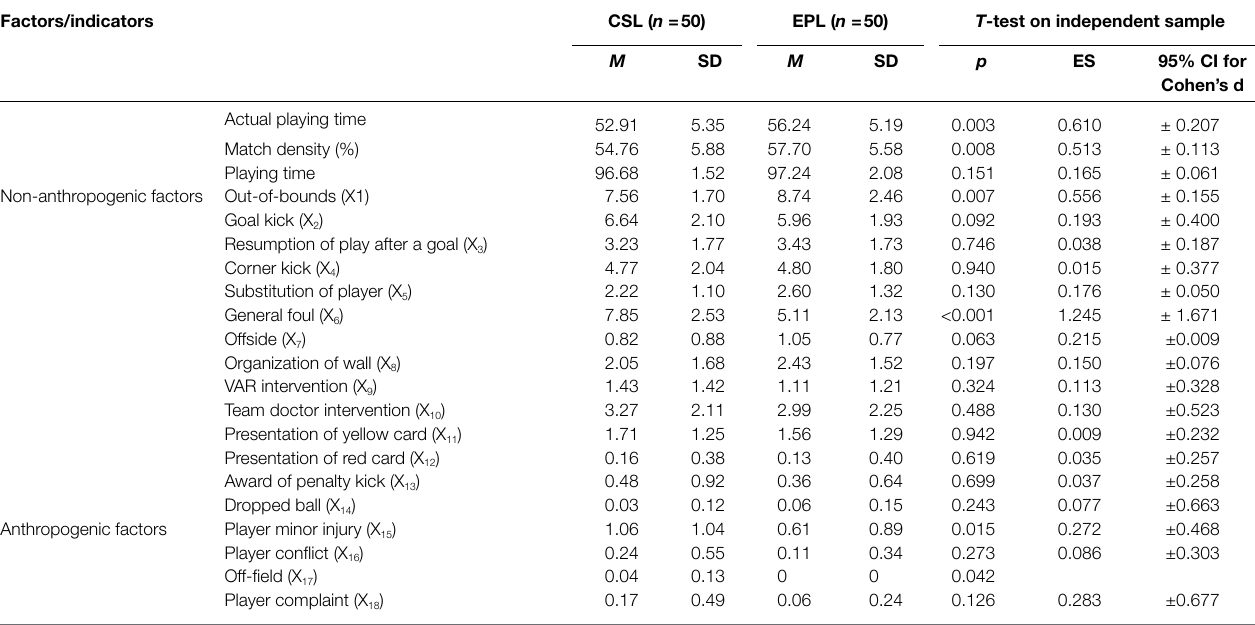
TABLE 3 | Comparison of average data of matches of the Chinese Super League (CSL) and English Premier League (EPL; time unit: minutes). Factors/indicators